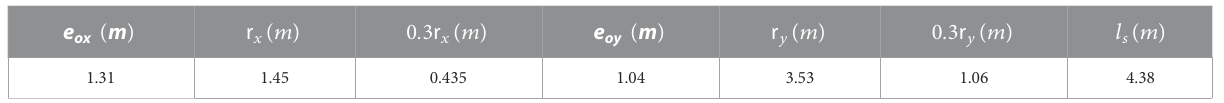
TABLE 2 Calculated irregularity